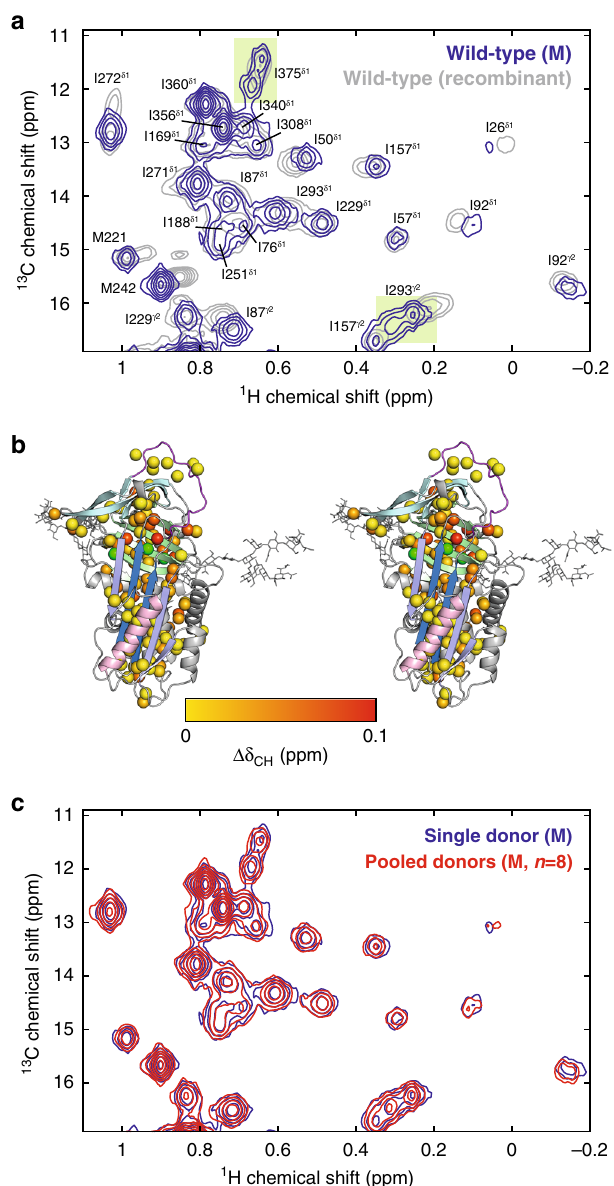
Fig. 4 Comparison of ex vivo M and recombinant WT AAT. a Comparison of 1 H, 13 C SOFAST-gHMQC spectra (isoleucine regions) of M AAT and U- 1 H, 13 C recombinant wild-type AAT (deconvolved using NUWS-NUS 44 ) (298 K, 900 MHz). Resonance assignments are indicated, and green shading highlights the presence of doubled peaks. b Stereo view of combined methyl chemical shift changes, Δ δ CH ¼ projected onto the AAT structure 72 with the most abundant M6 isoform glycans shown 45 , modelled using CHARMM-GUI 75 . Doubled methyl resonances are indicated in green. c Comparison of 1 H, 13 C SOFAST- gHMQC spectra (isoleucine region) of ex vivo M AAT puri fi ed from a single donor and from a pool of eight